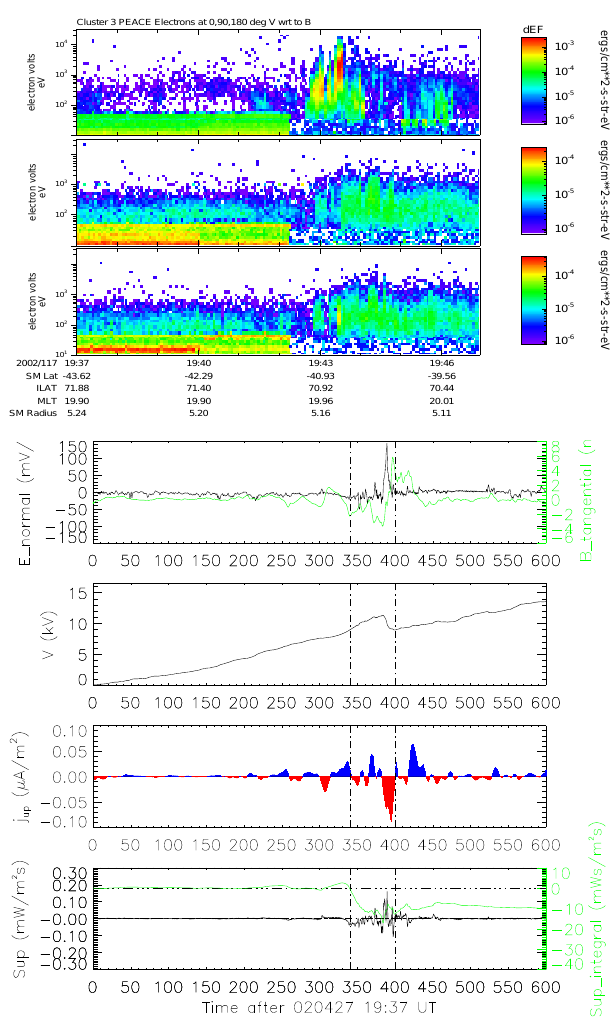
Fig. 10. 27 April 2002, s/c 3. The same panels as in Fig.